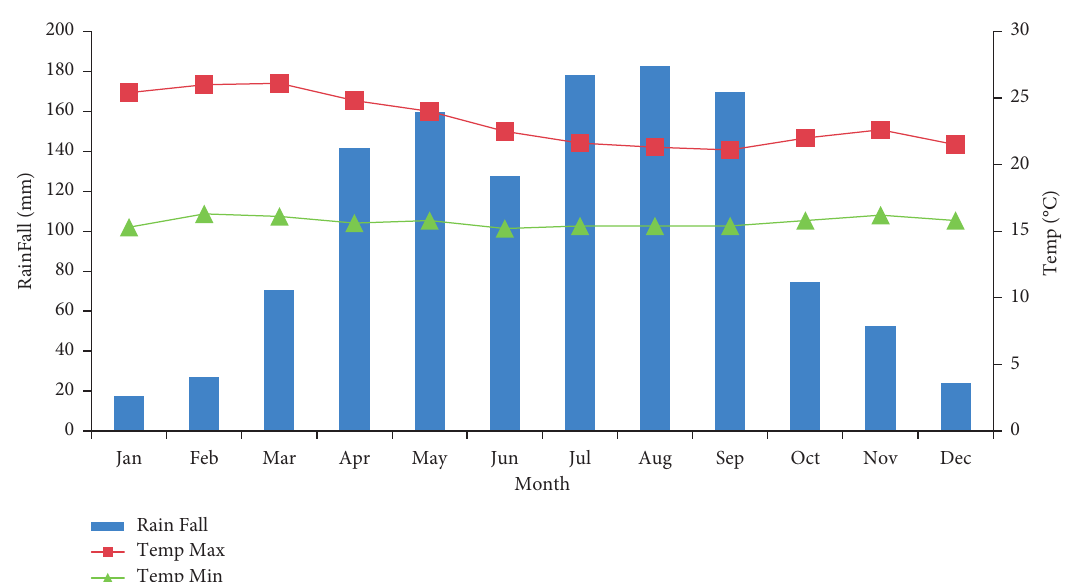
Figure 2: Nine-year (2008–2016) mean monthly rainfall and mean maximum and minimum temperatures of the study areas